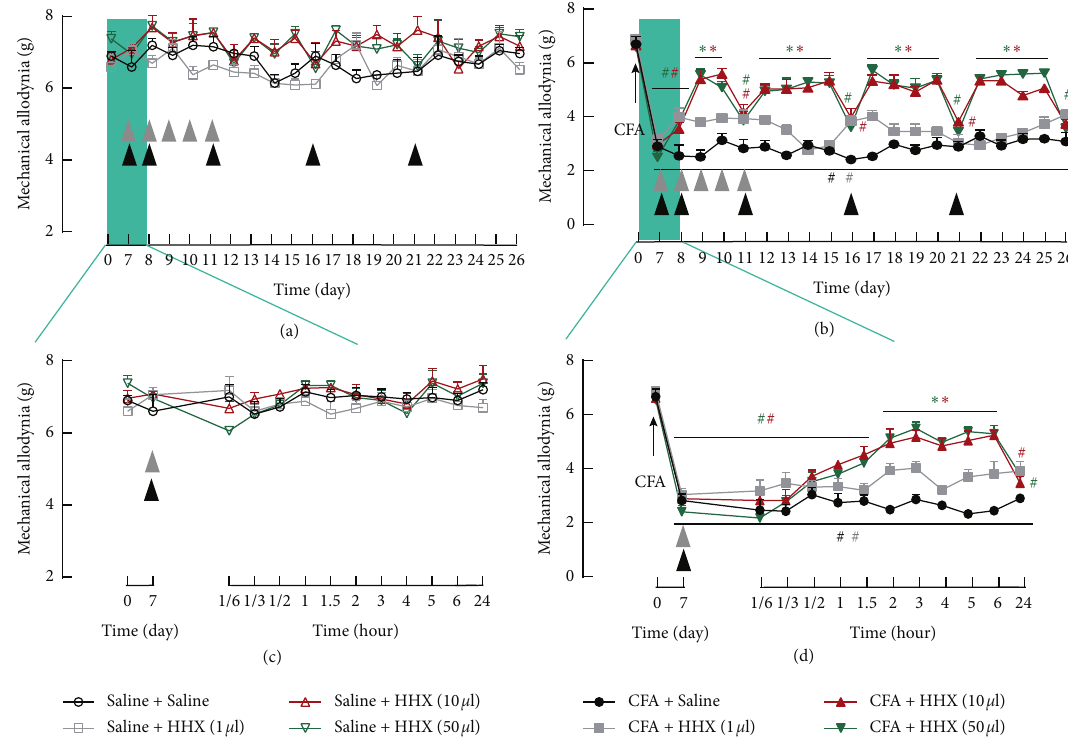
Figure 2: The time course of the effects of HHX (1, 10, and 50 μ l i.m.) on pain thresholds after saline (A and C) or CFA articular injection (B and D). (a) HHX at doses of 1, 10, and 50 μ l did not change the mechanical hypersensitivity after saline articular injection (time × group interaction, F (20, 200) � 1.264, P � 0 . 2072; F (20, 200) � 0.8155, P � 0 . 6932; F (20, 200) � 0.8660, P � 0 . 6303). (c) Rectangular box denoted postdrug administration behavioral assessment at different points in time after the first injection. Mechanical allogynia decreased moderately 10min after the first injection of HHX (50 μ l). (b) HHX at doses of 10 μ l and 50 μ l changed the mechanical hypersensitivity after CFA articular injection (time × group interaction, F (20, 200) � 7.859, P < 0 . 0001; F (20, 200) � 11.84, P < 0 . 0001). However, HHX at a dose of 1 μ l had no antinociceptive effects (time × group interaction, F (20, 200) � 1.336, P � 0 . 1596). (d) The rectangular box denotes postdrug administration behavioral assessment at different points in time after the first injection. The first injection of HHX provided rapid antinociception at the hind paw at 2h after the injection and lasted for approximately 4h. The time of the injection of HHX (1 μ l) is shown as gray arrows and HHX (10 and 50 μ l) shown as black arrows. ∗ P < 0 . 05 versus CFA +saline. # P < 0 . 05 versus